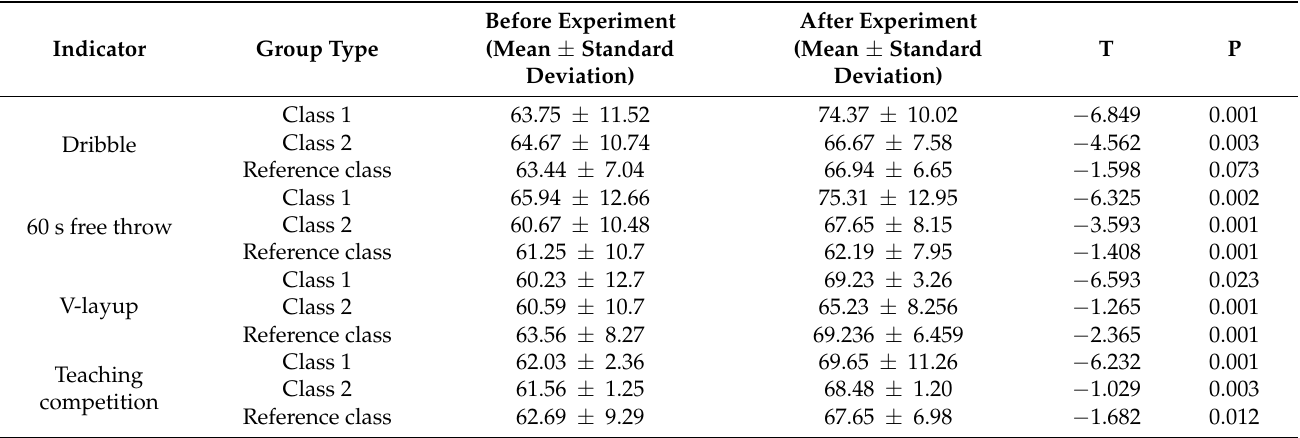
Table 6. Comparison and analysis table of the students’ basketball skills and technical and tactical application abilities before and after the